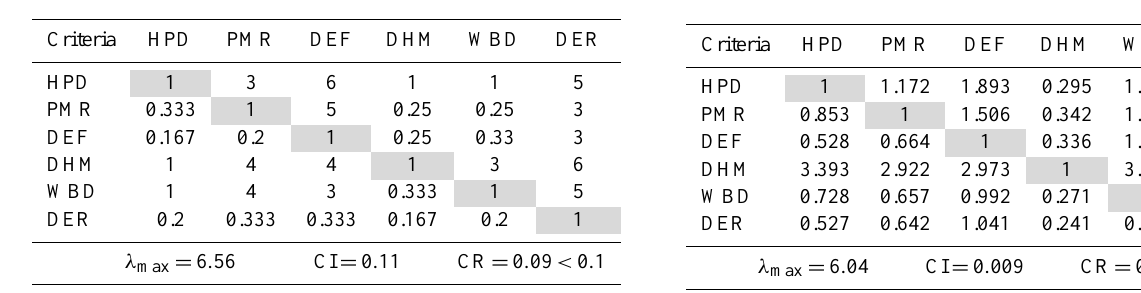
Table 2. Preference (pairwise comparison) matrix for one decision maker.